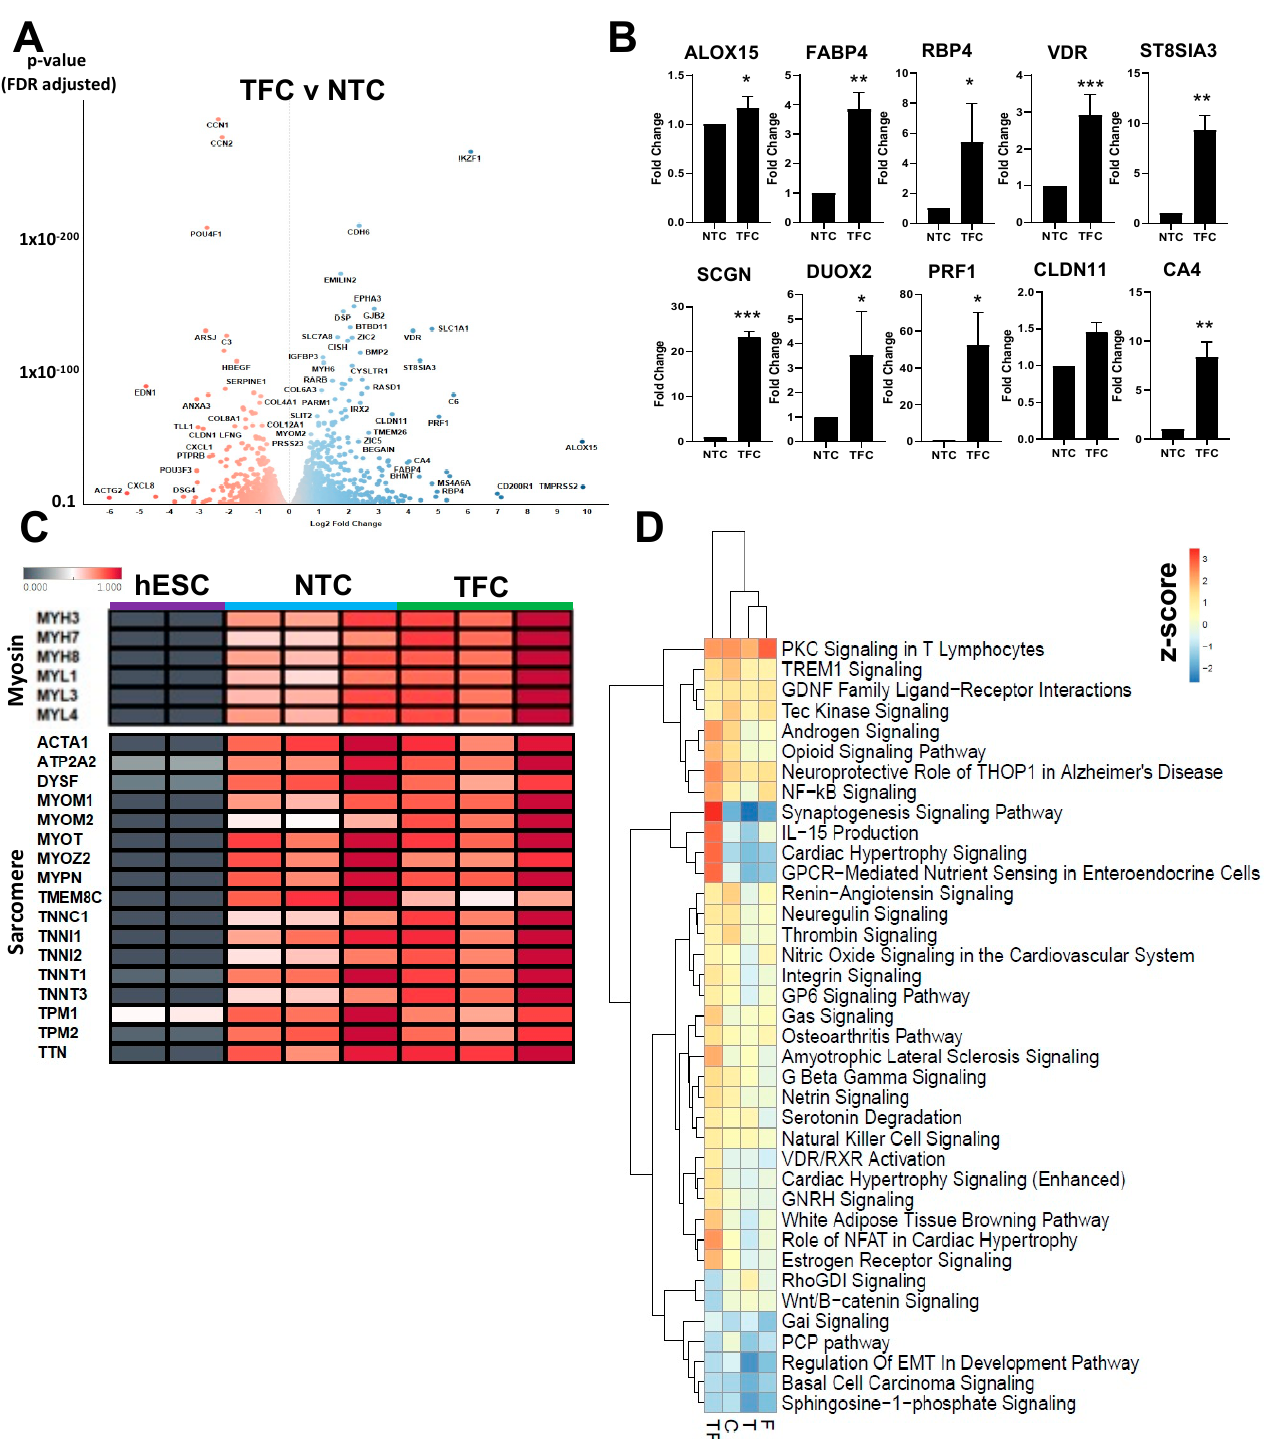
Figure 3. Transcriptomic profiling of NTC and TFC-treated hESC-SkMC. ( A ) Volcano plot of differentially expressed genes between TFC and NTC. ( B ) RT-qPCR validation of several top differentially expressed genes as identified via RNASeq. Statistical analysis was performed using a two-tailed t -test. * p < 0.05, ** p < 0.01, *** p < 0.001. ( C ) Heatmap comparison of various myosin and sarcomere genes between hESC, NTC and TFC-treated hESC-SkMC. ( D ) IPA comparative analysis of differentially regulated pathways in treated hESC-SkMCs compared to NTC. Shown are data pooled from three independent biological replicates.